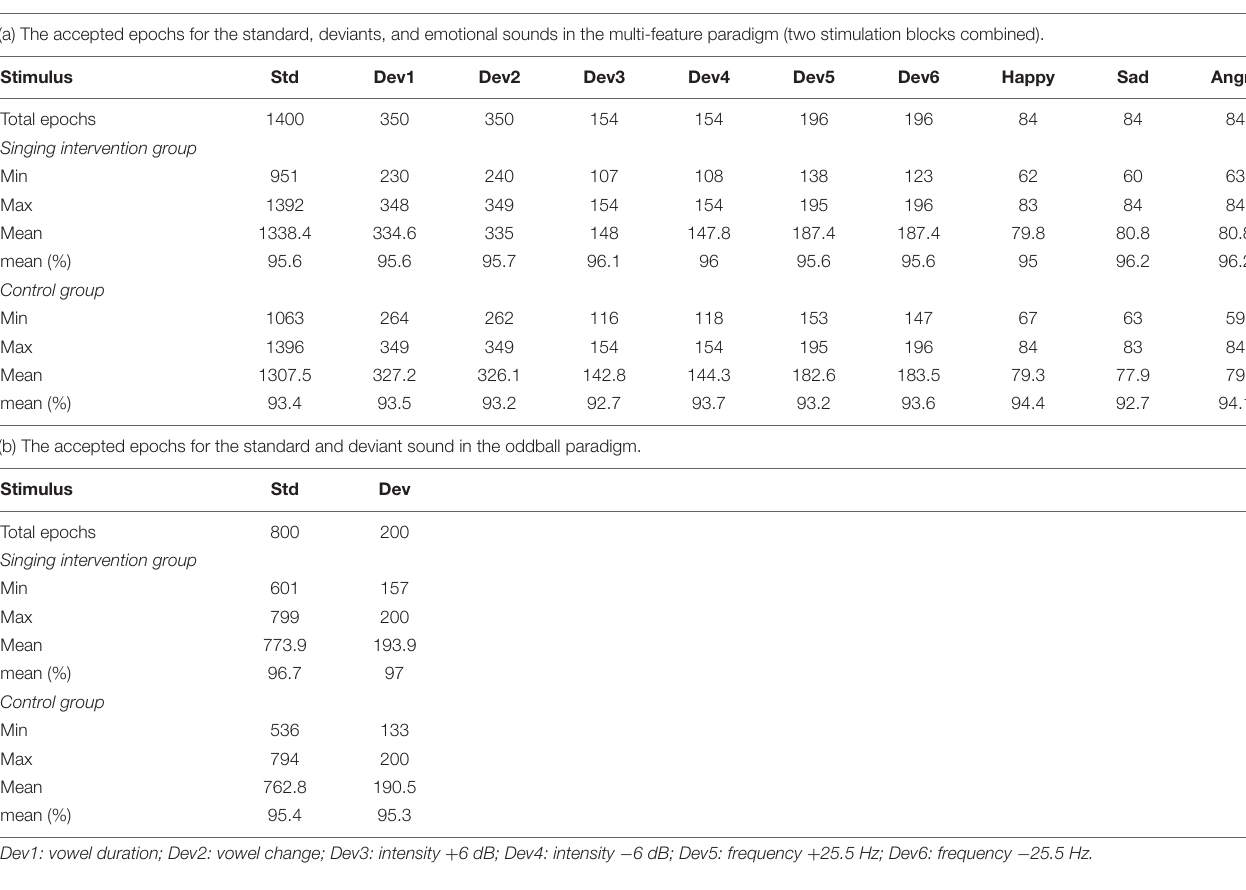
TABLE 3 | The accepted epochs in both